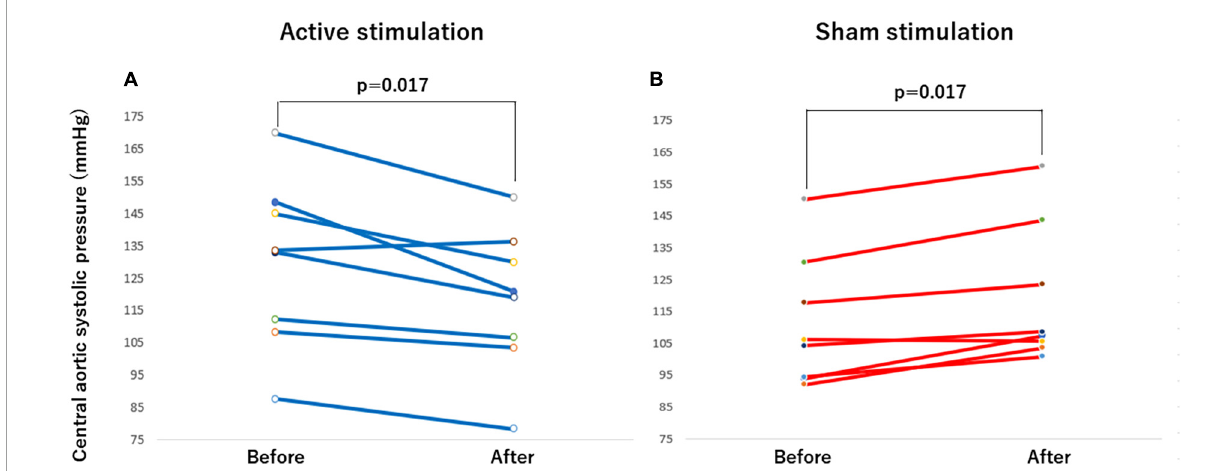
FIGURE4 Effect of active vs sham tVNS on measures of central aortic systolic pressure. (A) Active stimulation. (B) Sham stimulation. tVNS, transcutaneous vagus nerve stimulation.